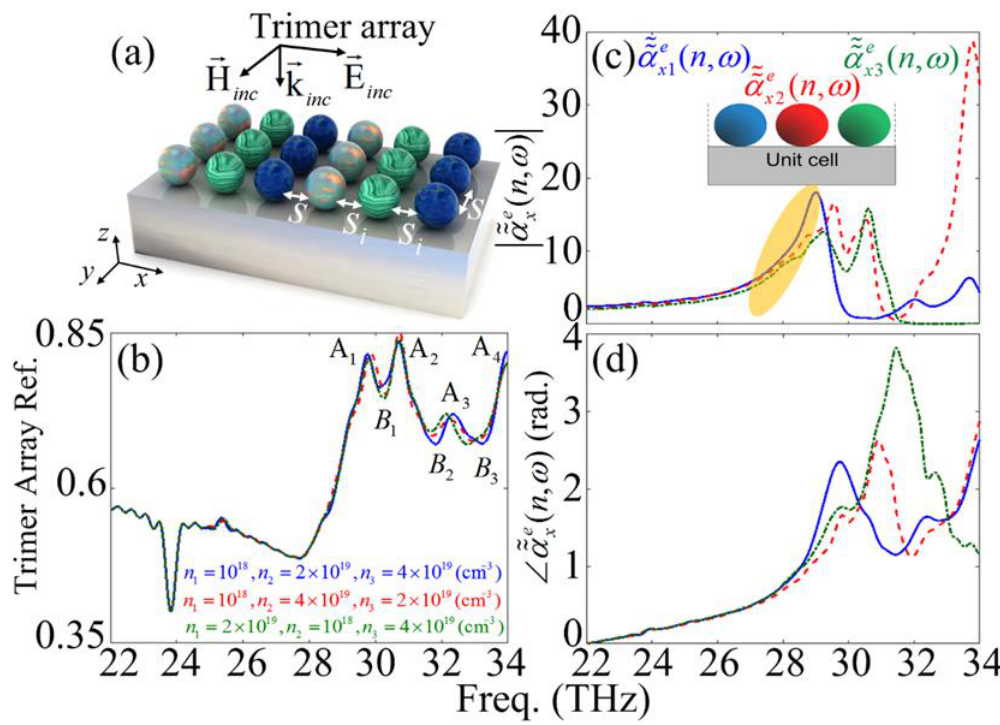
Figure 6. Schematic representation of the square patterned array composed of the SiC dimers ( a ) and trimers ( c ) with di ff erent doping values, respectively. ( b ); ( d ) n 1 = 10 18 , n 2 = 2 × 10 19 , and n 3 = 4 × 10 19 ( cm − 3 ) (solid curve), n 1 = 10 18 , n 2 = 4 × 10 19 , and n 3 = 2 × 10 19 ( cm − 3 ) (dashed curve) and n 1 = 2 × 10 19 , n 2 = 10 18 , and n 3 = 4 × 10 19 ( cm − 3 ) (dashed-dotted curve), respectively.